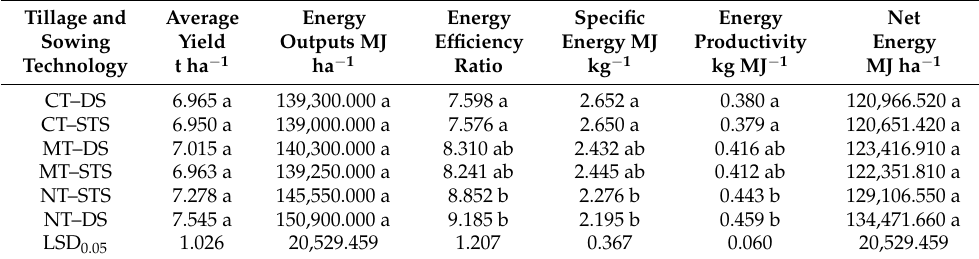
Table 5. Yield and energy efficiency indicators of winter wheat production.